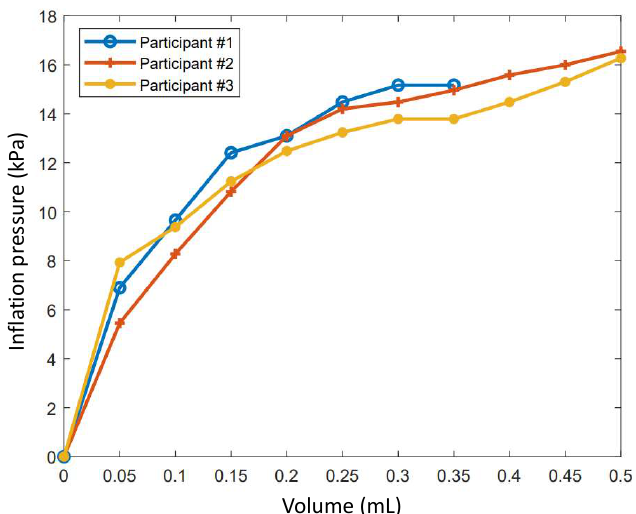
Figure 4. Earplug pressure–volume curves for three test subjects during inflation of the earplug within the earcanal.